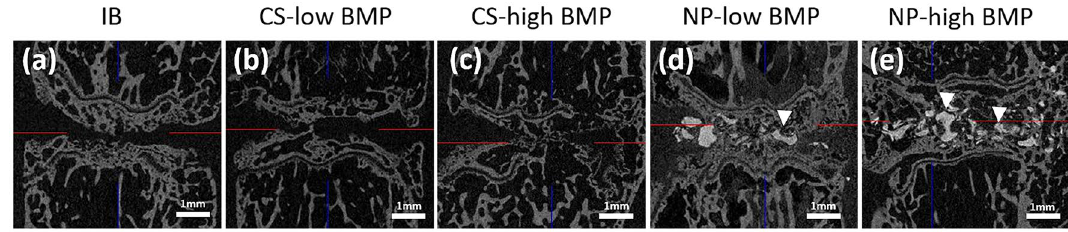
Figure 1. Ex vivo micro-CT images of treated segments. Representative coronal micro-CT images of treated intervertebral discs in each group. In the IB group, the grafted bone almost disappeared, and no bridging new bone formation was observed ( a ). In the CS-low and -high BMP groups, new bone formation that partly bridged the intervertebral disc space was observed, but the bone volume and density were low ( b , c ). In the NP-low and NP-high groups, the intervertebral disc space was occupied by dense new bone formation with a small amount of HA particles ( d , e